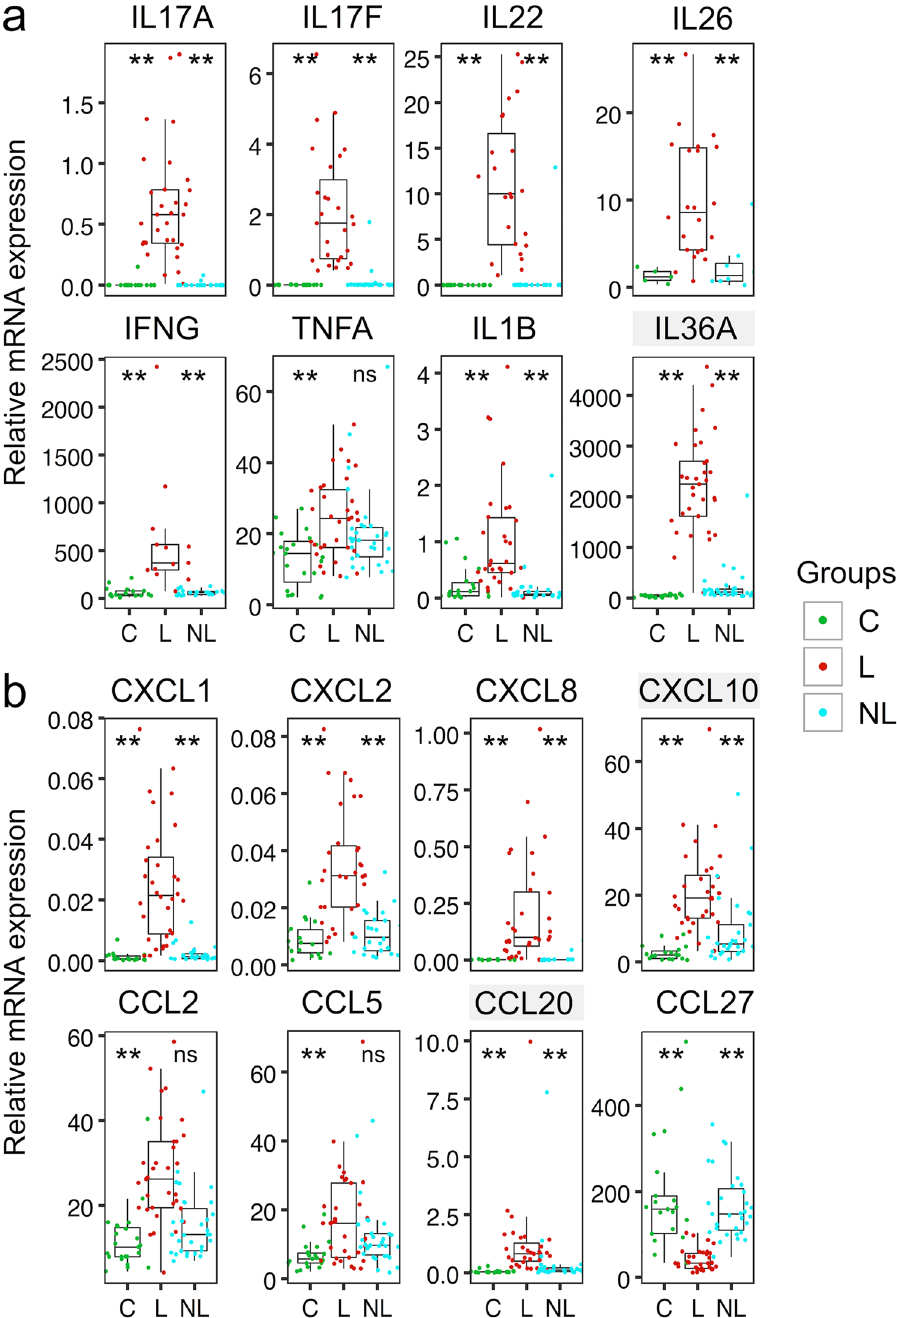
Figure 1. Inflammatory cytokine and chemokine expression is elevated in psoriatic lesions. QRT-PCR was used to quantify the expression of inflammatory cytokines ( a ) and chemokines ( b ) relative to ACTB in skin biopsy samples obtained from lesional (L) and non-lesional (NL) skin of psoriasis patients as well as from age-matched control individuals (C). The box-and-whisker plots depict median (central line), interquartile range (IQR, Q1-Q3, box), Q3 + 1.5 × IQR (upper whisker) and Q1 − 1.5 × IQR (lower whisker). Stars above the groups C and NL depict their significance level from L samples. ** P < 0.001, * P < 0.05. Grey shading behind the gene name indicates statistically significant differences between NL and C biopsy samples (for IL36A P = 1.70 * 10 − 5 , CXCL10 P = 0.0019, CCL20 P =